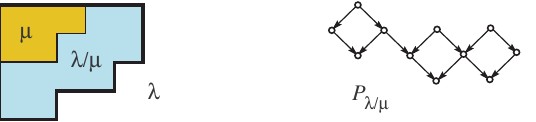
Figure 1.2: Skew Young diagram λ / µ and poset P